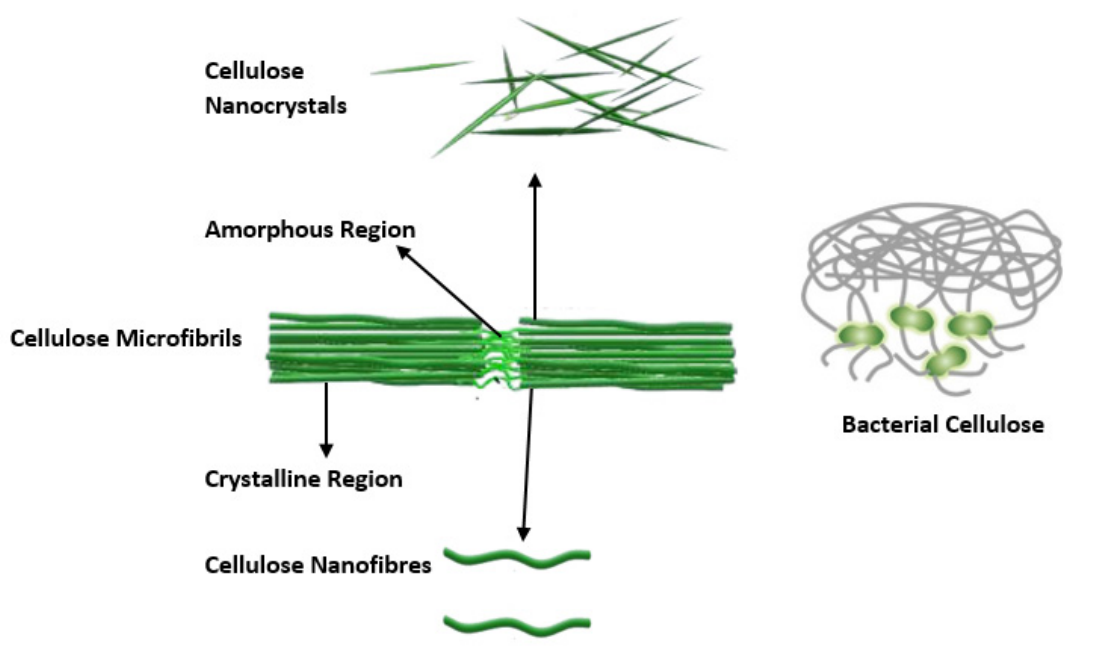
Figure 3. Different types of nanocellulose.